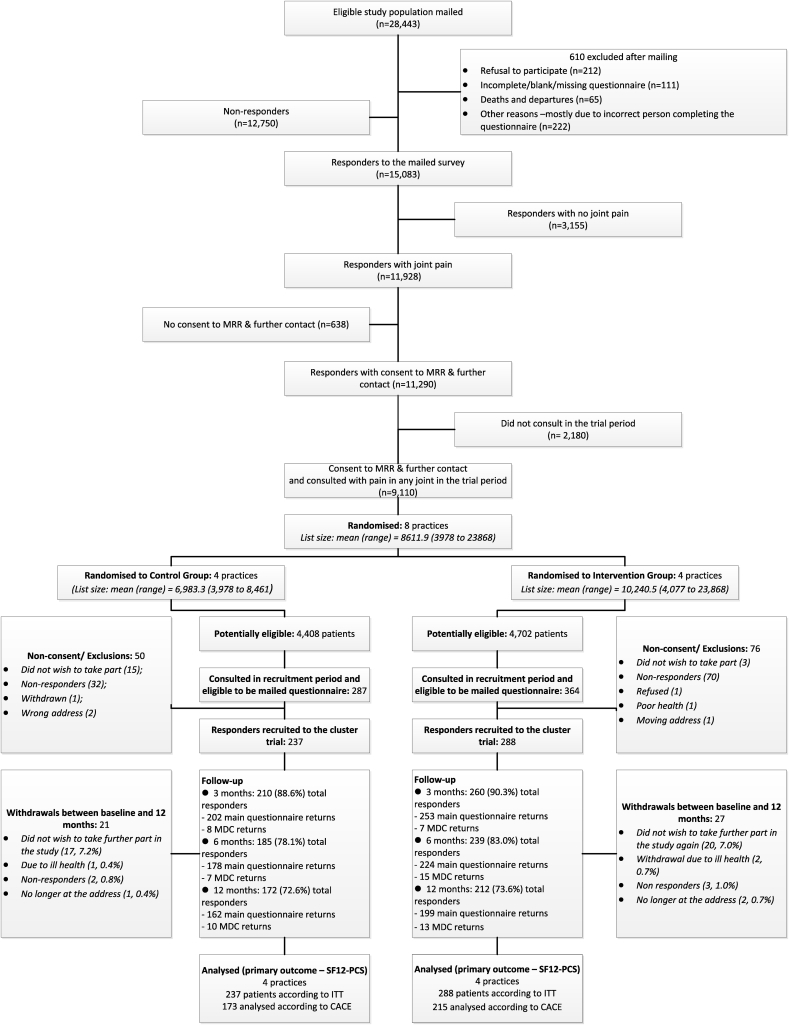
Study flow chart.